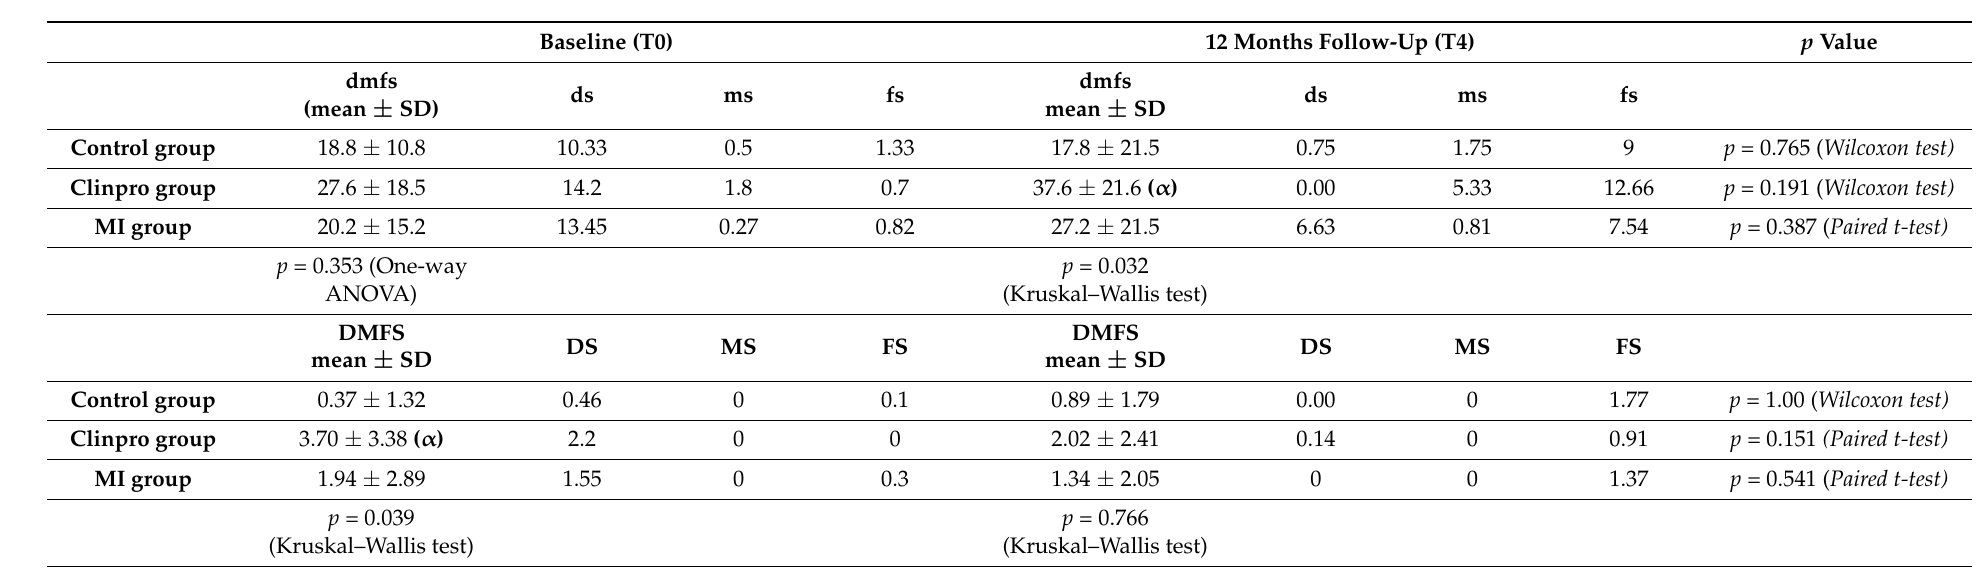
Table 3. The DMFS and dmfs index